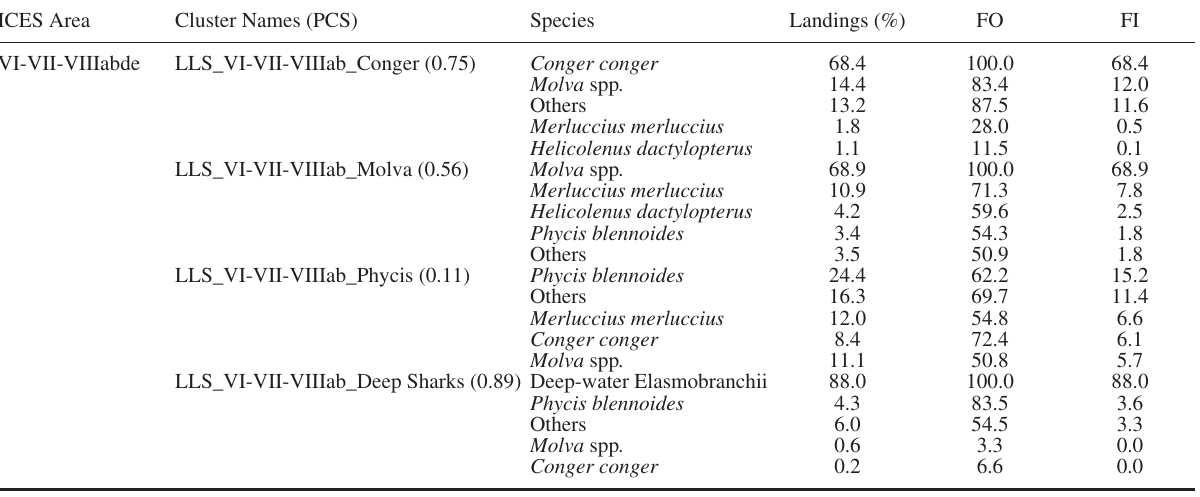
Table 4. – Catch profile (percentage in weight, frequency of occurrence and feeding index) by cluster and area for longline in VI, VII and VIIIab ICES divisions (PCS: partial coefficient silhouette).